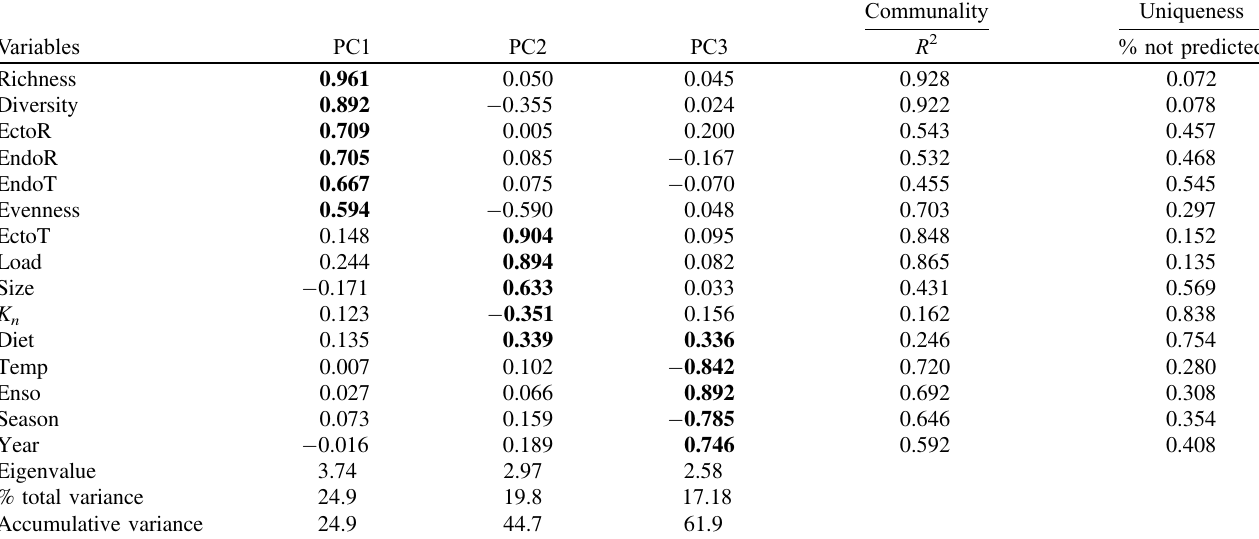
Table 3. Summary of the principal component analysis (PCA) on biotic and abiotic factors that in fl uence the diversity and species richness of the infracommunities of Caranx sexfasciatus . The three principal component axes are indicated by PC1, PC2 and PC3, respectively. Variables that contribute to the total explained variance in each PC are in bold. Eigenvalues, percentage of variance, and accumulative variance are shown at the end of the table. Communality = total in fl uence of the variable with respect to all other associated variables. Uniqueness = percentage of variability that is not predicted by the variable in the model.